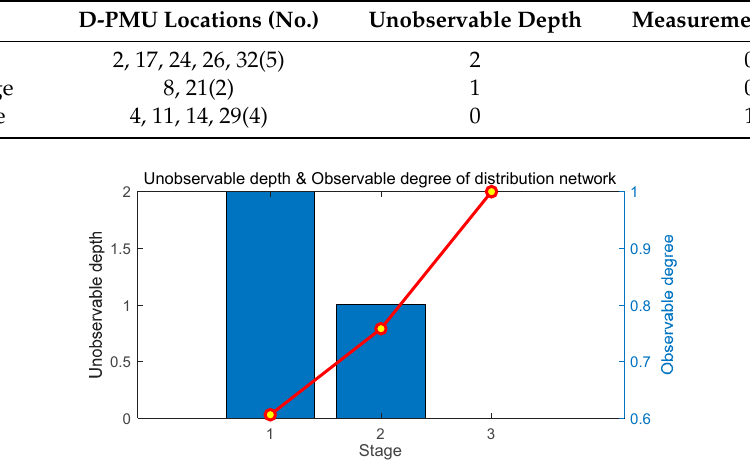
Figure 10. Unobservable depth and observable degree of the IEEE 33 bus system.